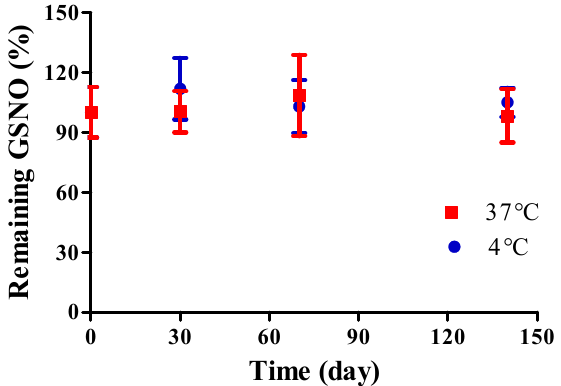
Figure 3. Storage stability of NO / GP at 4 (blue) and 37 ◦ C (red). Remaining GSNO percentage compared with that of initial NO / GP was calculated to evaluate storage stability. Each point represents the mean ± standard deviation ( n = 3).